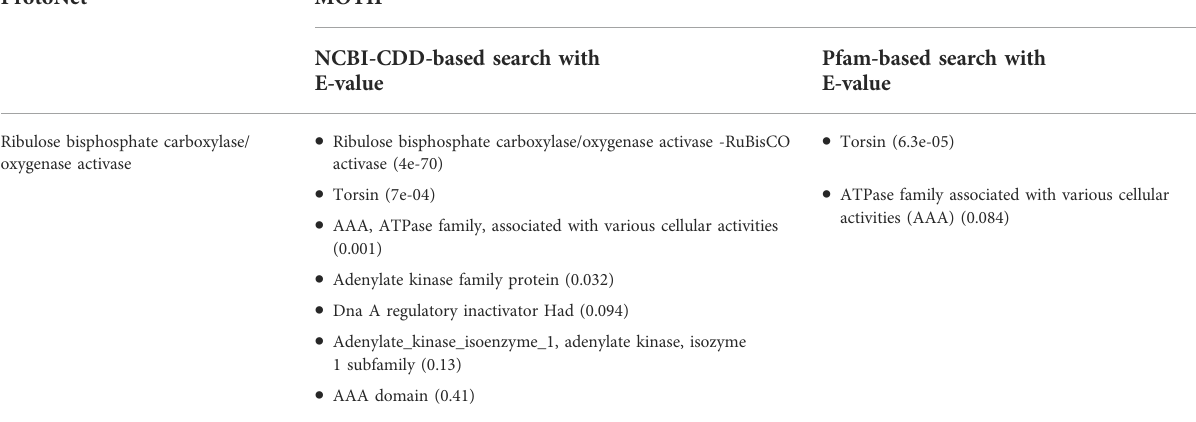
TABLE 1 Functional motifs of Ds-DbRCaG-01-Rga1 predicted through Motif prediction tools, ProtoNet, and MOTIF. ProtoNet